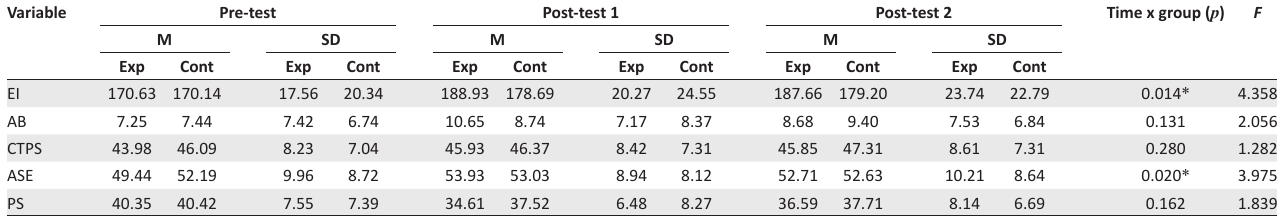
TABLE 1: Descriptive statistics and mixed-model Repeated-measures ANOVA results.